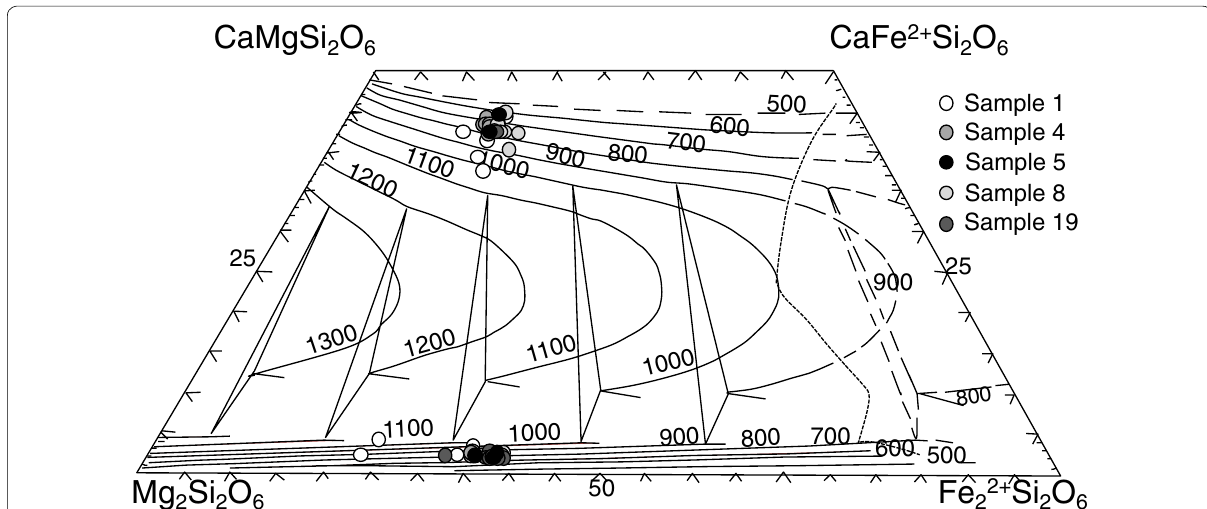
Fig. 5 Pyroxene phenocryst edge compositions obtained by EPMA analyses plotted on a pyroxene quadrilateral diagram with the 5-kbar isotherms of Lindsley (1983). The edges of isolated pyroxene phenocrysts were